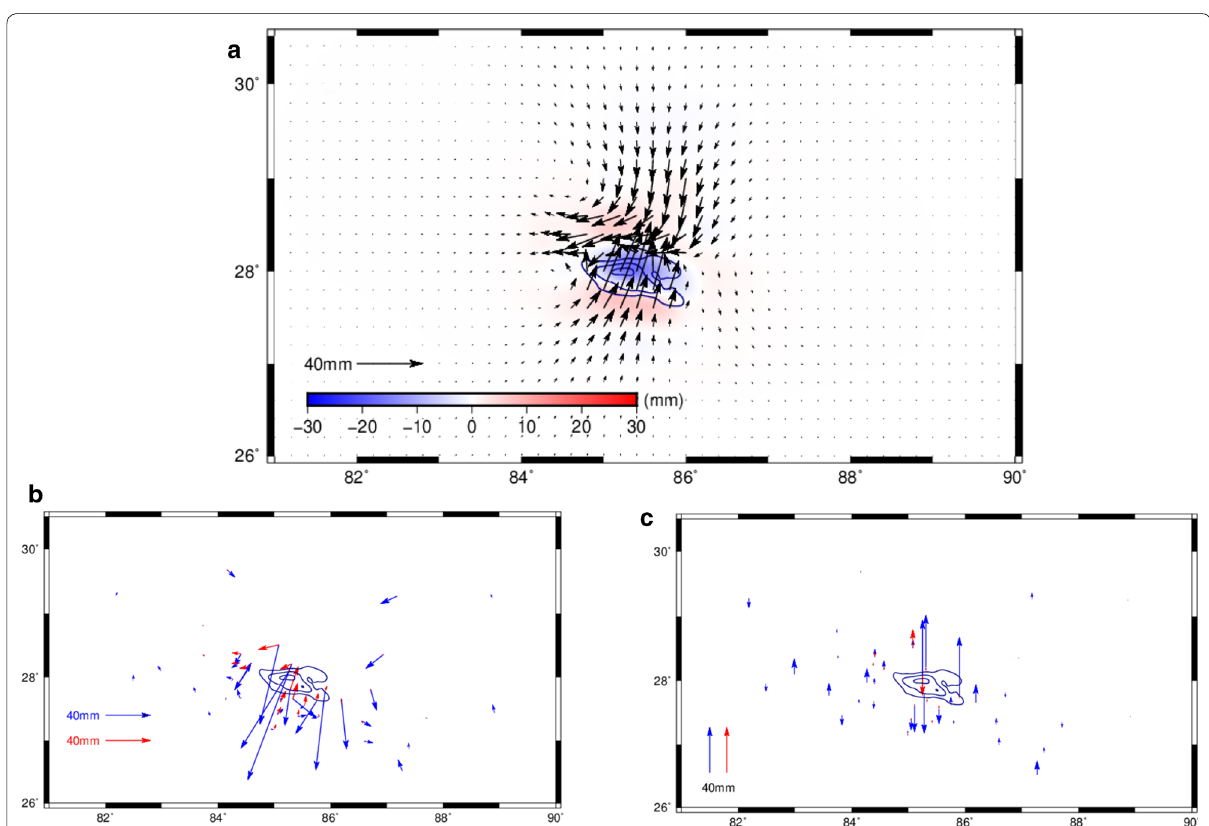
Fig. 4 The predicted postseismic displacements due to a bi-viscoelastic Burgers model. a The color scale represents the vertical component, and the black arrows represent the horizontal component. b The comparison between the predicted viscoelastic relaxation (red arrows) and observations (blue arrows) in the horizontal component and c the vertical component. The dark blue contours denote the coseismic slip distribution on the fault